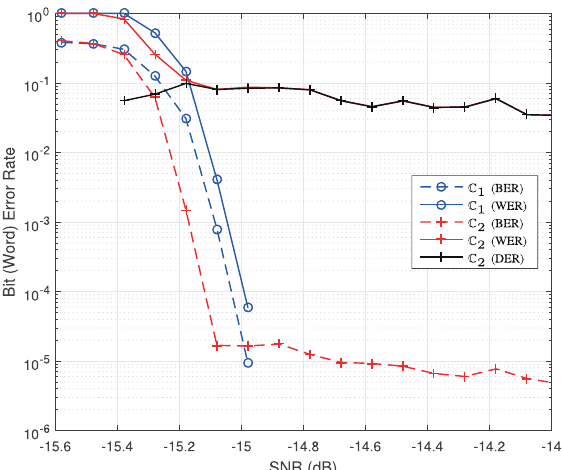
Fig. 2 BER and WER comparison between existing MET-LDPC code and optimized MET-LDPC code. Based on the degree distributions of C 1 and C 2 , two MET-LDPC codes of length 10 6 are implemented with random parity-check matrices, and they are denoted by C 1 and C 2 , respectively.